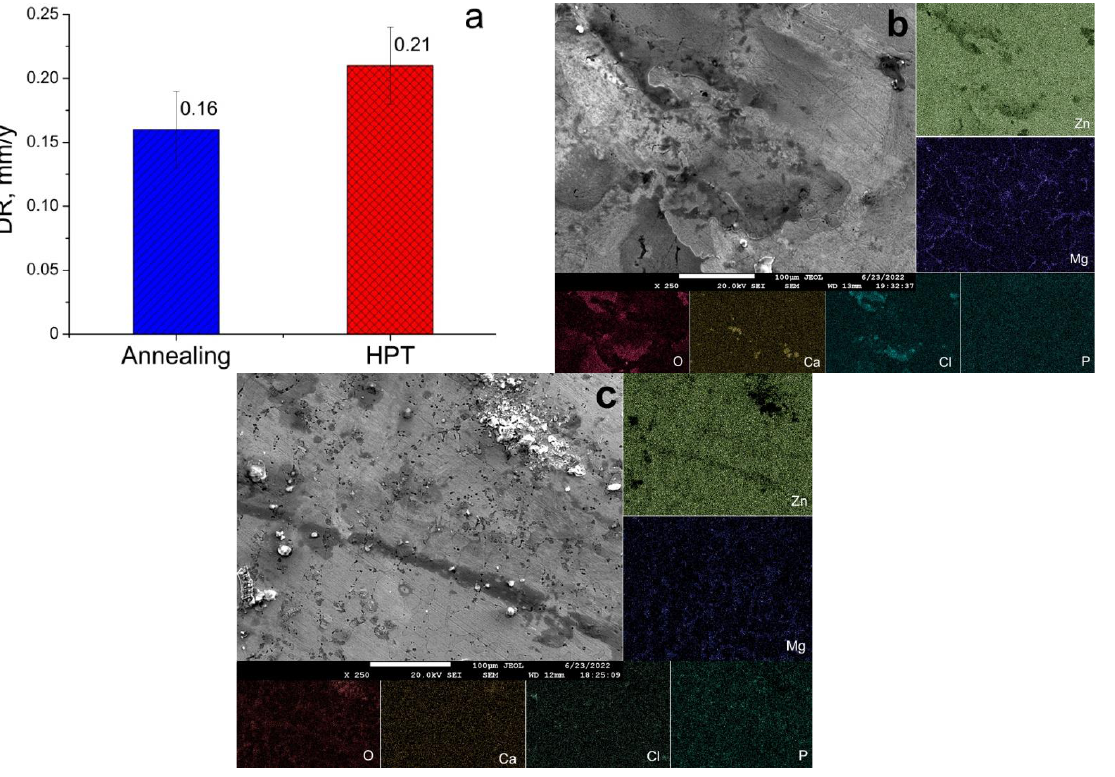
Figure 5. Degradation rate (DR) of the alloy in the annealed and HPT-treated conditions in vitro ( a ) and SEM images of corroded surfaces and elemental mapping of annealed ( b ) and HPT-treated ( c ) alloy samples after incubation in DMEM for 8 days.